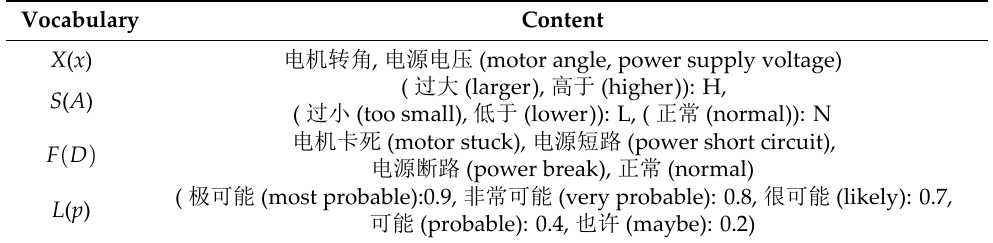
Table 5. Custom vocabularies.